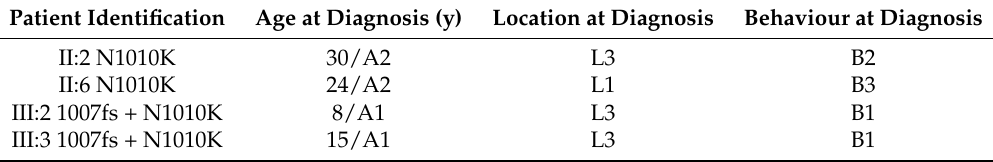
Table 2. Montreal classification for CD. L1, pure small bowel involvement; L2, pure colonic involvement; L3, small and colonic involvements; B1, nonstricturing and non-penetrating; B2, stricturing; B3,